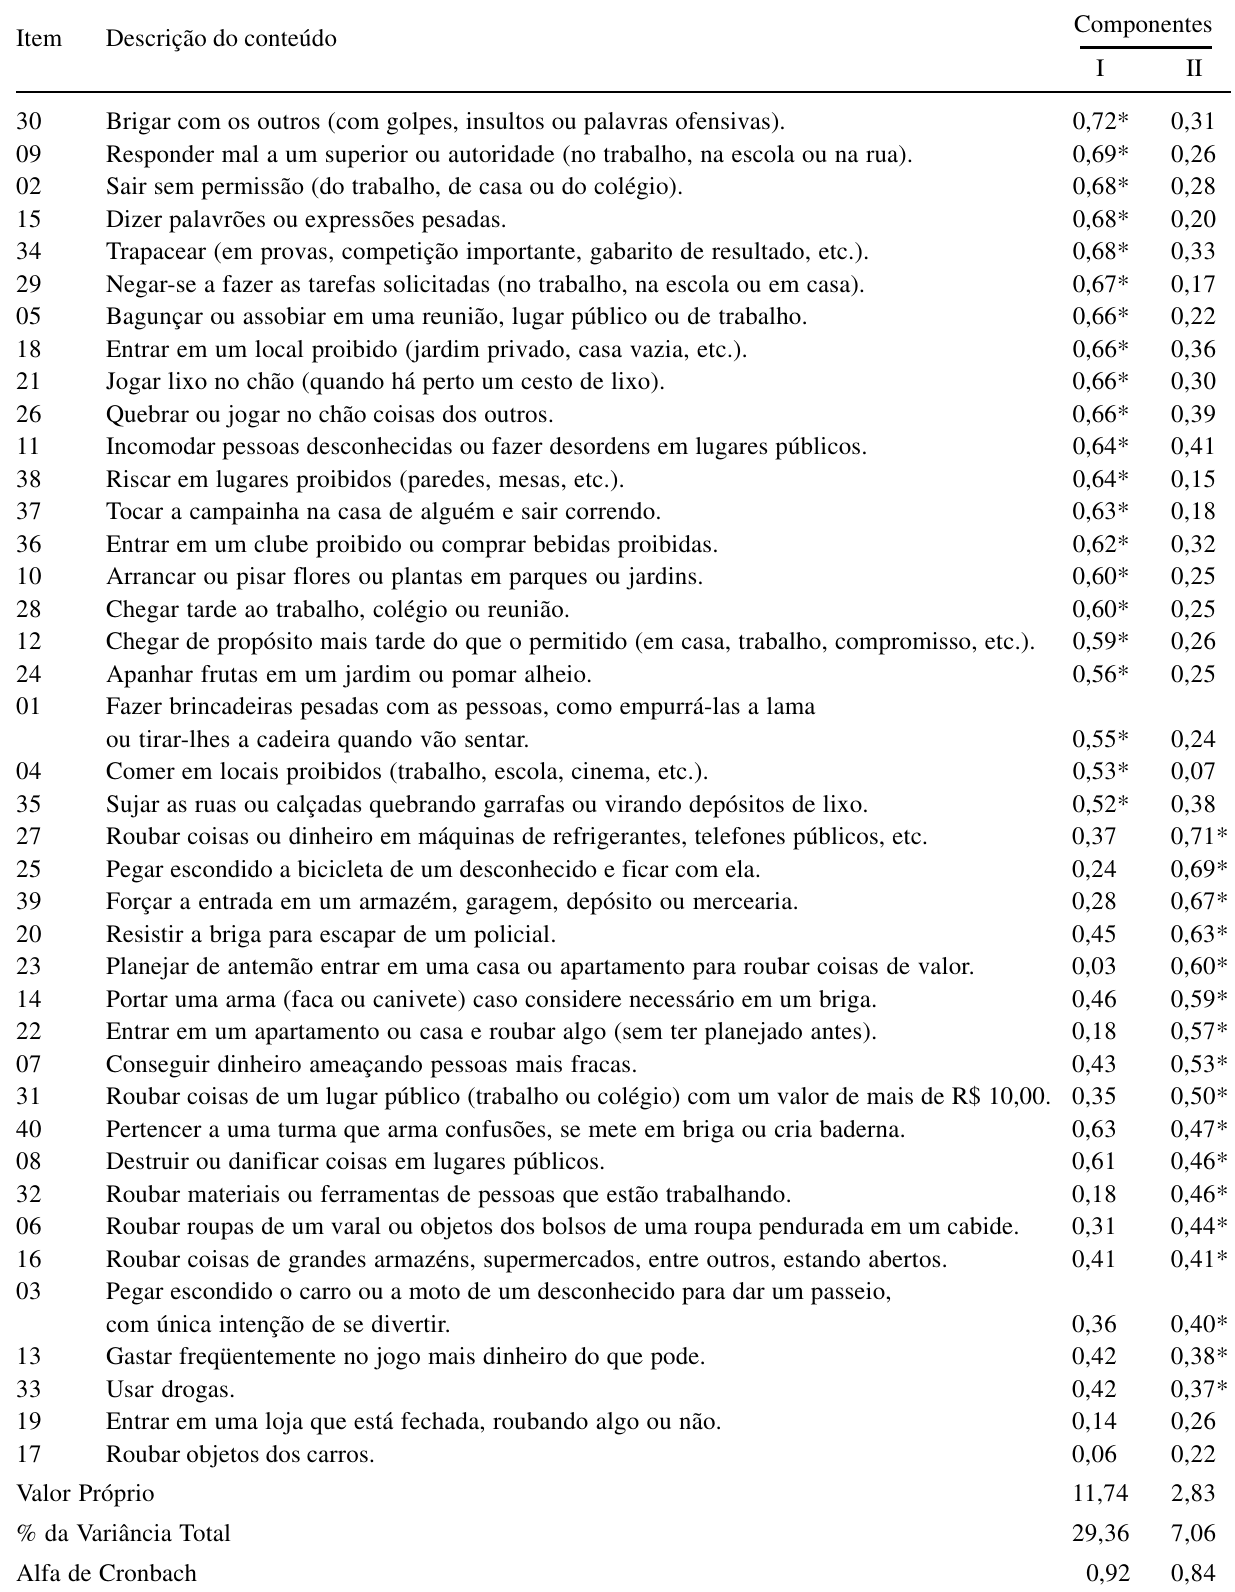
Tabela 1 Estrutura Fatorial do Questionário de Comportamentos Anti-sociais e Delitivos (CAD-40) Item Descrição do